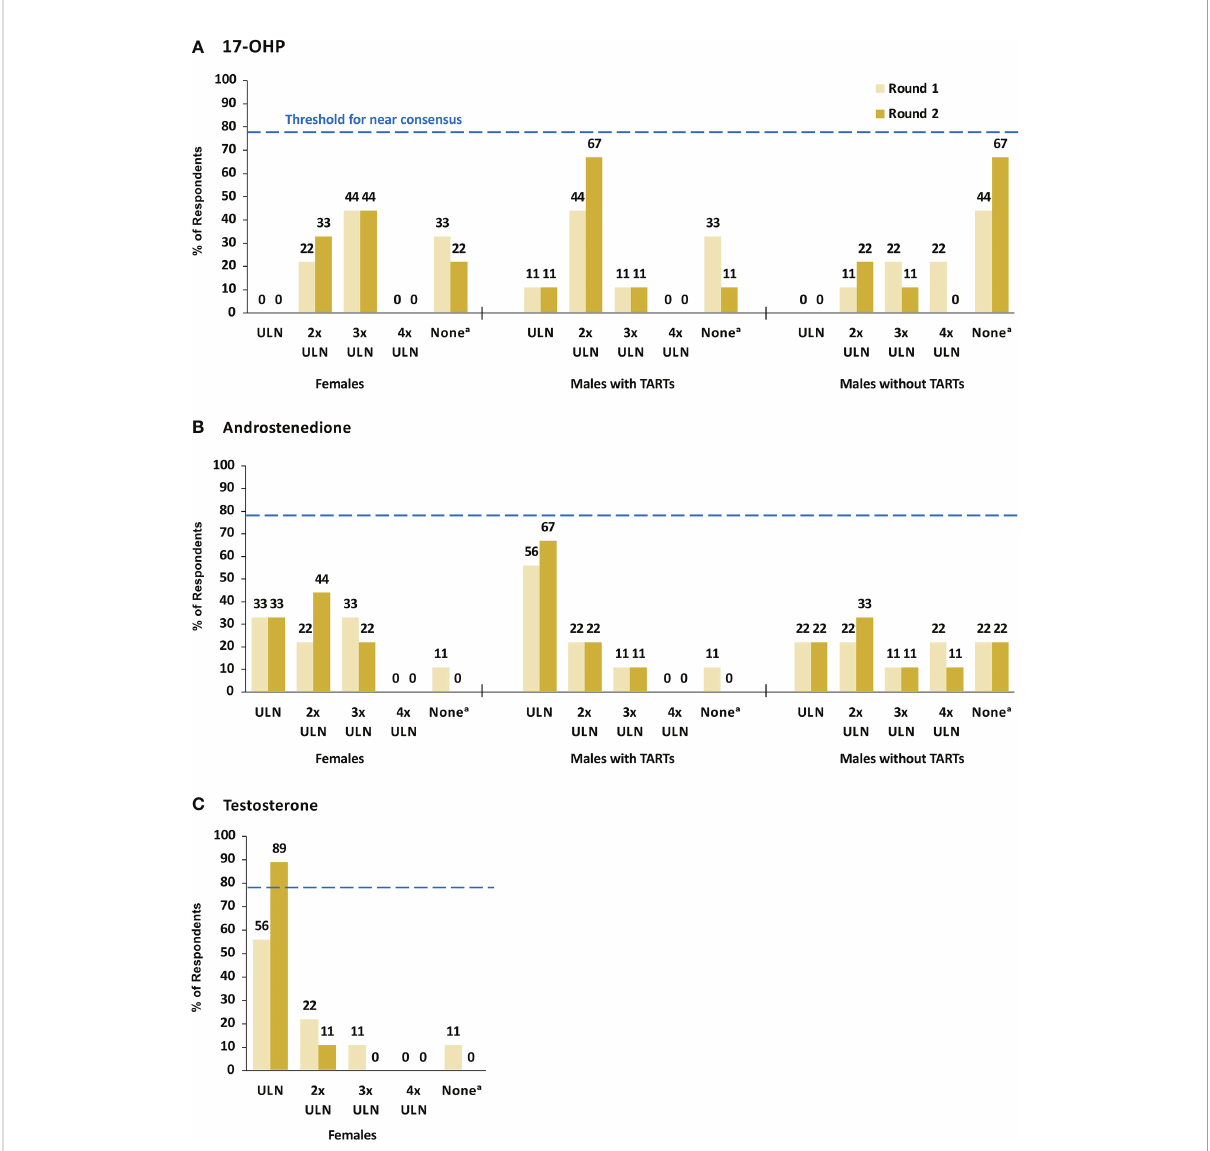
FIGURE 2 17-OHP (A) , Androstenedione (B) , and Testosterone (C) Laboratory Values Indicating Good Control. Dashed line indicates minimum threshold for near consensus (78%, or 7/9 respondents). a The survey response option for this category was “ I do not have a lab range I treat to ” .